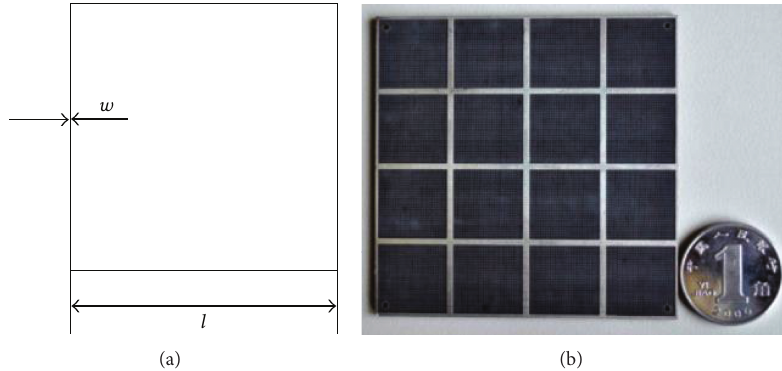
Figure 1: Zero index metamaterial, (a) the unit cell and (b) the sample.